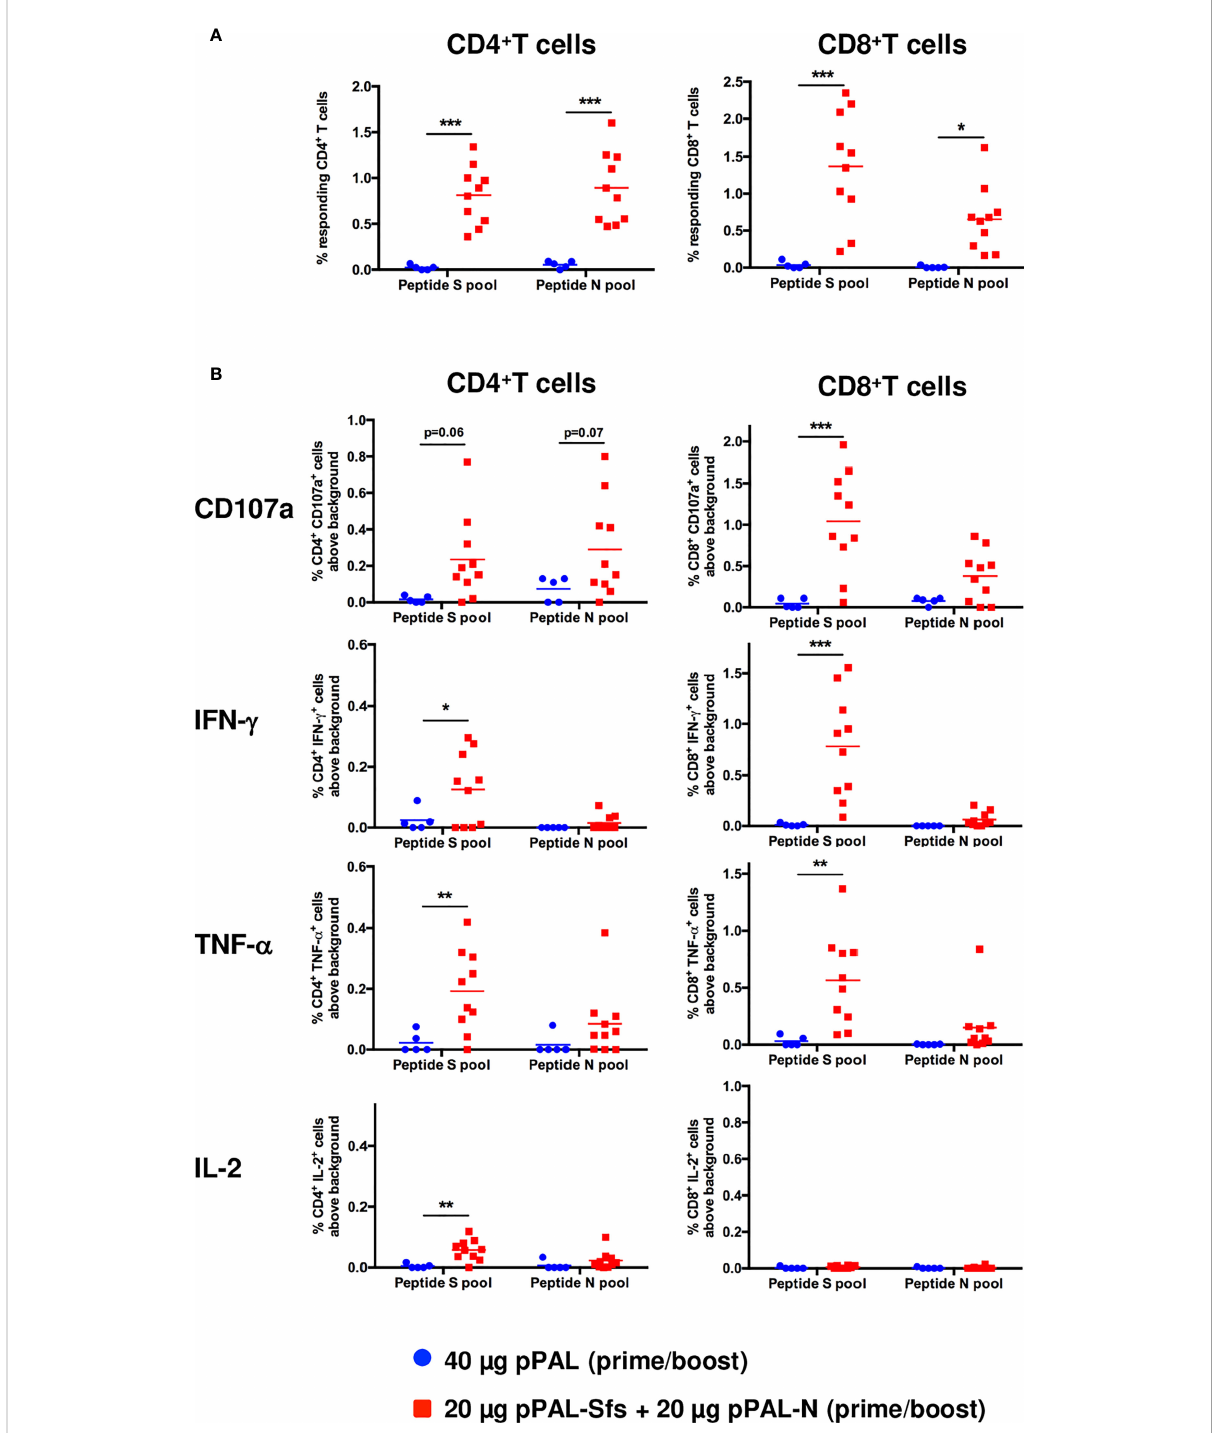
FIGURE 4 Speci fi c CD3 + CD4 + and CD3 + CD8 + T-cell response induced by pPAL-Sfs + pPAL-N in C57BL/6J mice. Splenocytes were obtained from mice after prime/boost inoculation with pPAL and pPAL-Sfs + pPAL-N. Splenocytes were stimulated for 4 h with 11-mer 8 amino acid-overlap peptide pools representing the whole S and N amino acid sequences in equimolar amounts. (A) Percentage of CD3 + CD4 + and CD3 + CD8 + T cells producing CD107a, IFN- g , TNF- a , and IL-2 in response to stimulation with peptide S or N pools. (B) Percentage of CD4 + and CD8 + T cells responding to S and N peptide pools above background, calculated as the sum of T cells positive for CD107a and/or IFN- g and/or TNF- a and/or IL-2. Statistical inference using Two-way ANOVA with Fisher ’ s LD post-hoc test (*p<0.05; **p<0.01;